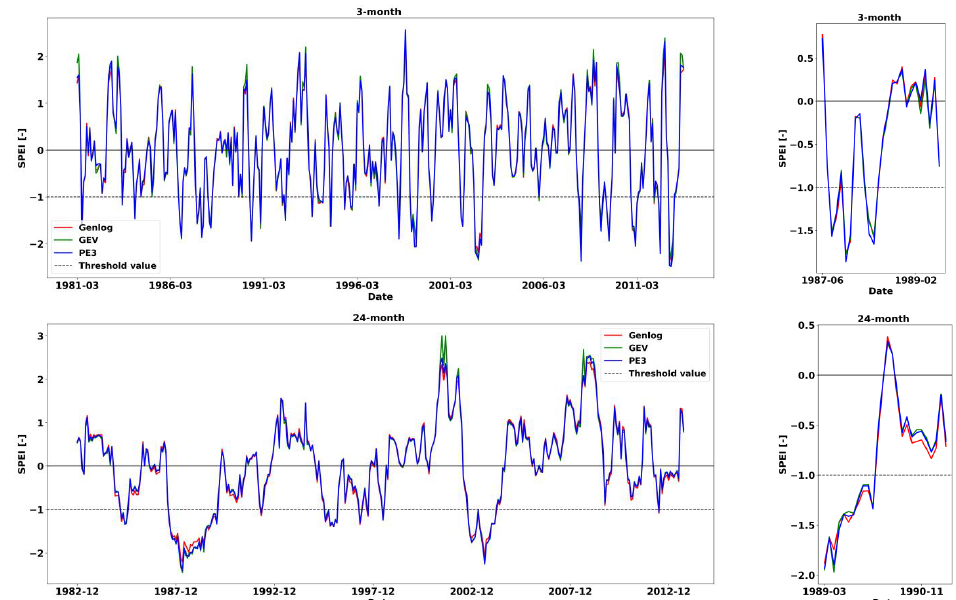
Figure 3. Comparison between the SPEI time series estimated based on the PE3, GEV, and Genlog distributions for 3 and 24 accumulation periods at Melkasa (IAR) gauging station. Zoomed-in plot is given on the side for both 3- and 24-month aggregation